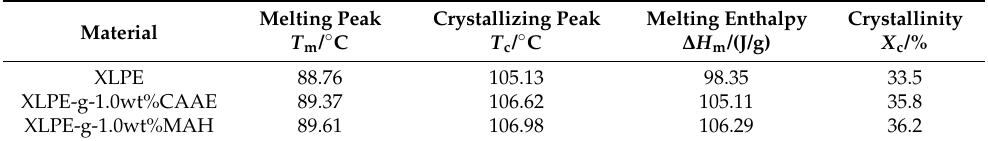
Figure 3. DSC temperature spectra of XLPE, XLPE-g-1.0wt%CAAE and XLPE-g-1.0wt%MAH in melting ( left panel ) and crystallizing ( right panel ) processes. Table 1. Melting–crystallization characteristics and the calculated crystallinities.